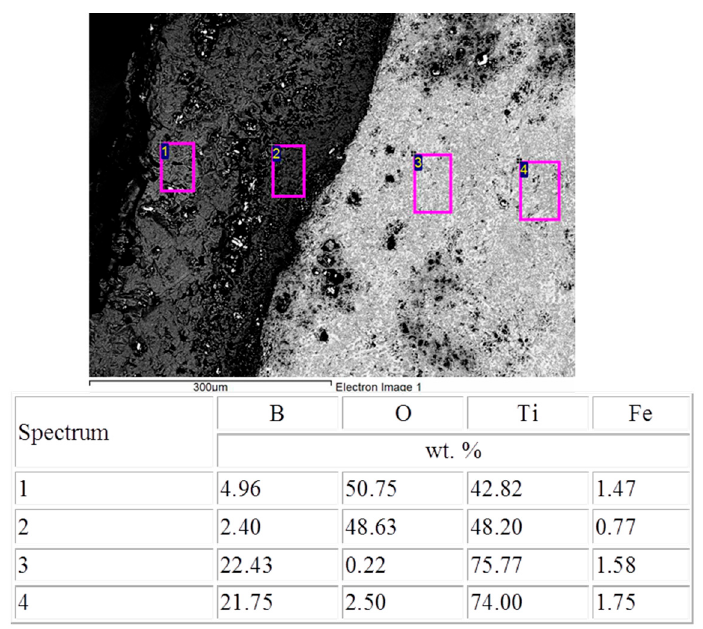
Figure 6. SEM images of the sample after oxidation at 1100 °C for 10 h.